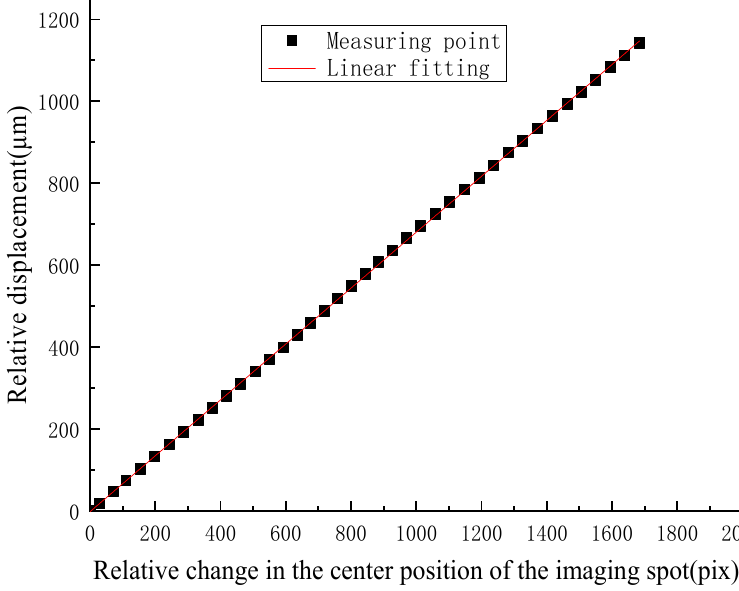
Figure 8. Parameter calibration. Figure 8. Parameter